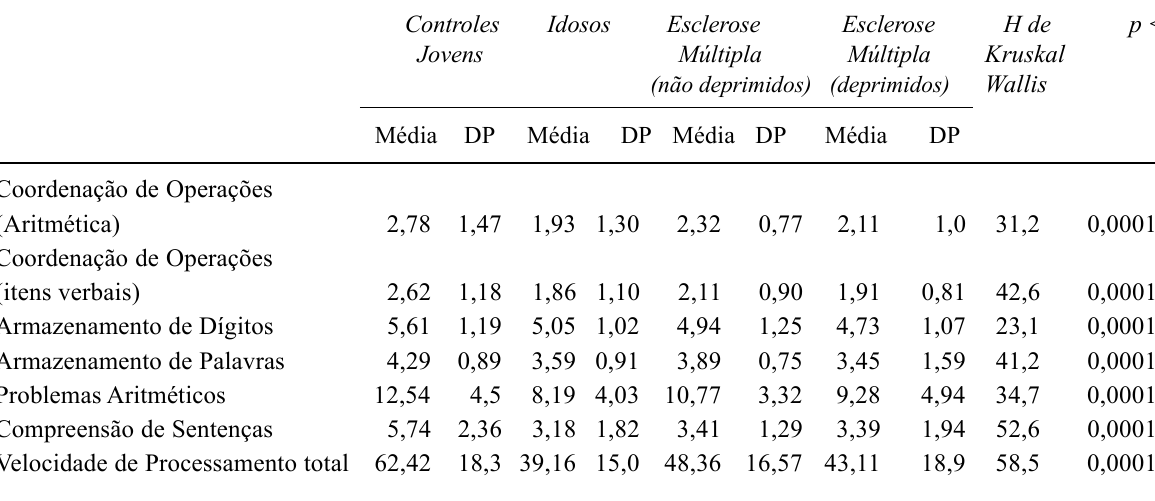
A Figura 7 apresenta o desempenho dos quatro grupos na tarefa de velocidade de processamento total,